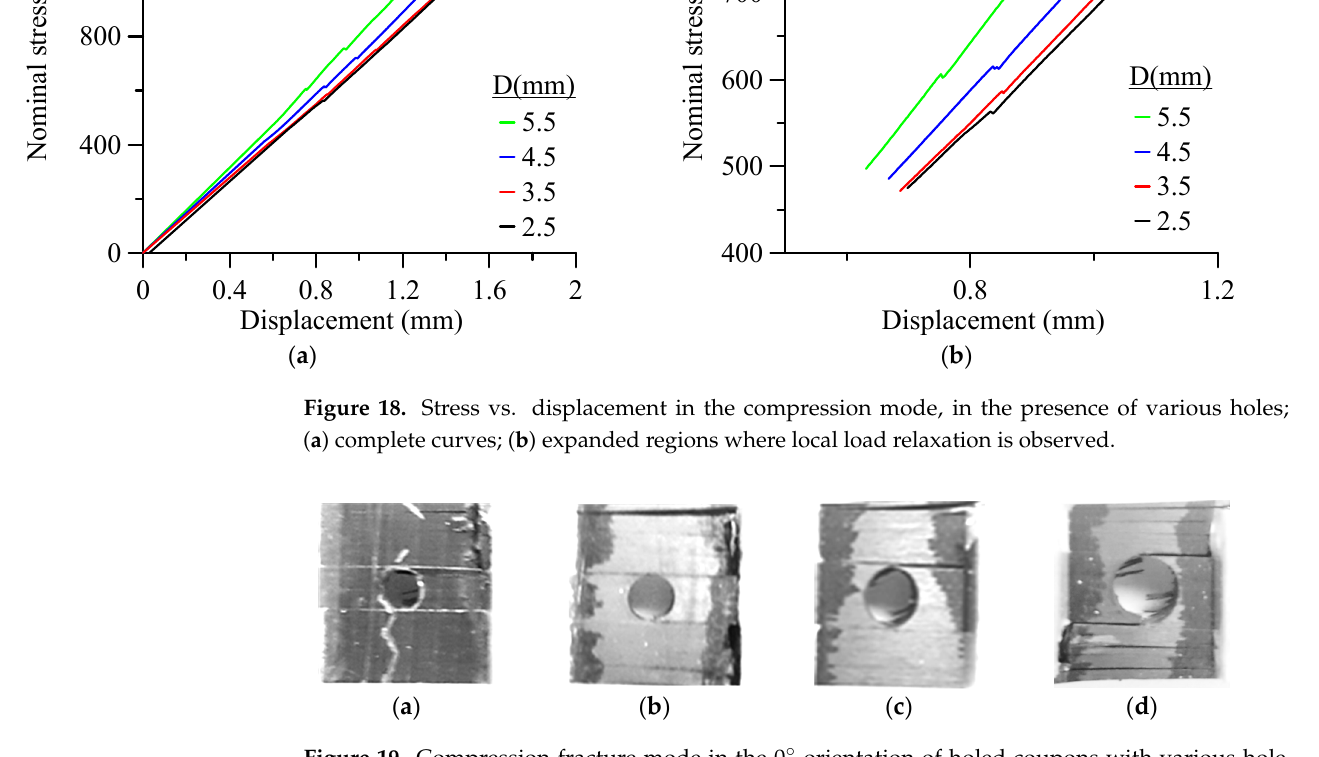
Figure 19. Compression fracture mode in the 0° orientation of holed coupons with various hole diameter; ( a ) 2.5 mm; ( b ) 3.5 mm; ( c ) 4.5 mm; ( d ) 5.5 mm.